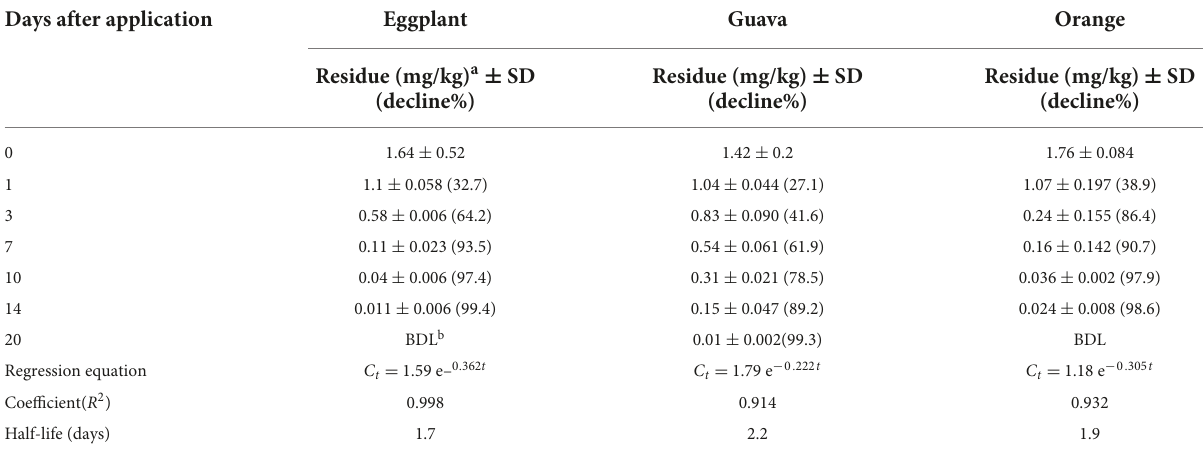
TABLE 4 Fenpyroximate decline kinetics in eggplant, guava, and orange fruit.